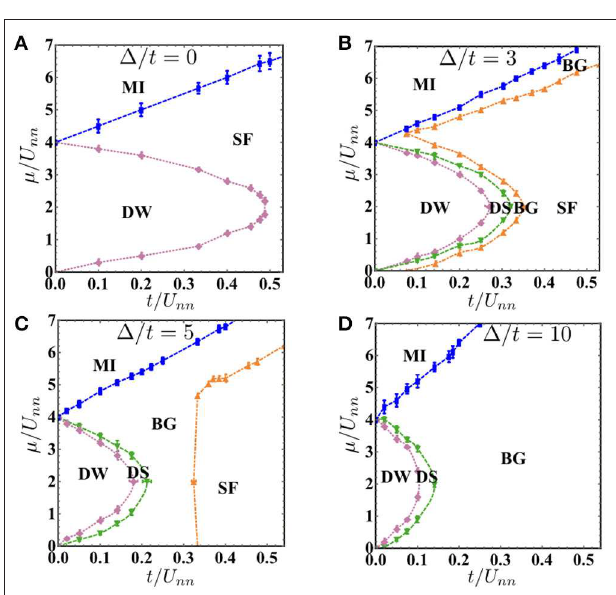
FIGURE 4 | Ground state phase diagrams of model 2 as a function of t / U nn and µ/ U nn for clean system (A) , and disordered system with disorder strength 1/ t = 3 (B) , 5 (C) , and 10 (D) ,